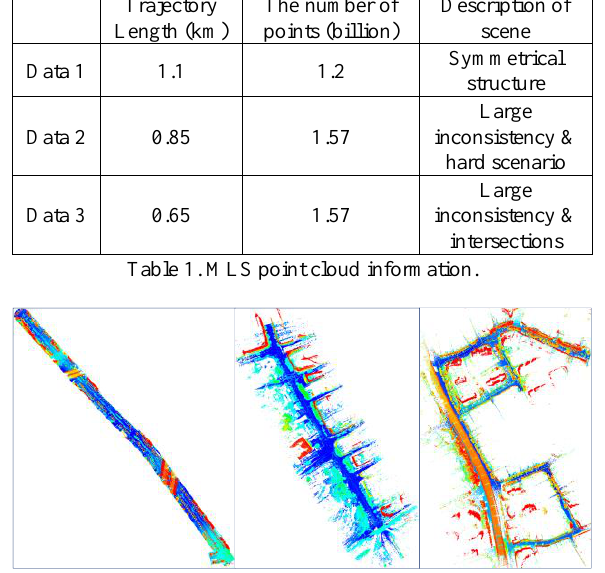
Figure 5. The overview of point clouds Data